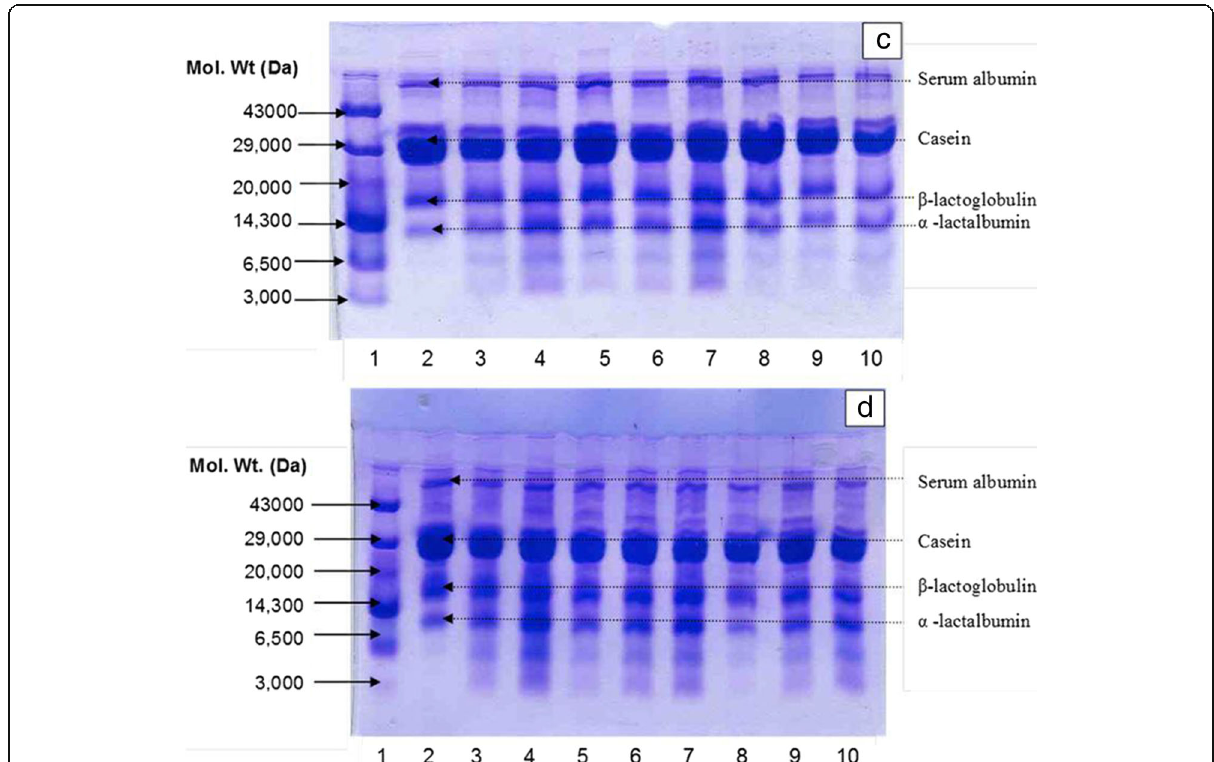
Fig. 2 c Tricine SDS-PAGE of milk enriched with hydrolyzates from 10% protein solution. Lane1 - Standard; lane 2 - toned milk; lane 3, 4 - milk enriched with 10 and 20% (v/v) hydrolyzate of DH 5%, respectively; lane 5, 6, 7 - milk enriched with 5, 10, 20% (v/v) hydrolyzates of DH 7%, respectively; lane 8, 9, 10 - milk enriched with 5, 10, 20% (v/v) hydrolyzate of DH 9%, respectively. d 15% protein solution. Lane1 - Standard; lane 2 - toned milk; lane 3, 4 - milk enriched with 10 and 20% (v/v) hydrolyzate of DH 5%, respectively; lane 5, 6, 7 - milk enriched with 5, 10, 20% (v/ v) hydrolyzate of DH 7%, respectively; lane 8, 9, 10 - milk enriched with 5, 10 and 20% (v/v) hydrolyzate of DH 9%,